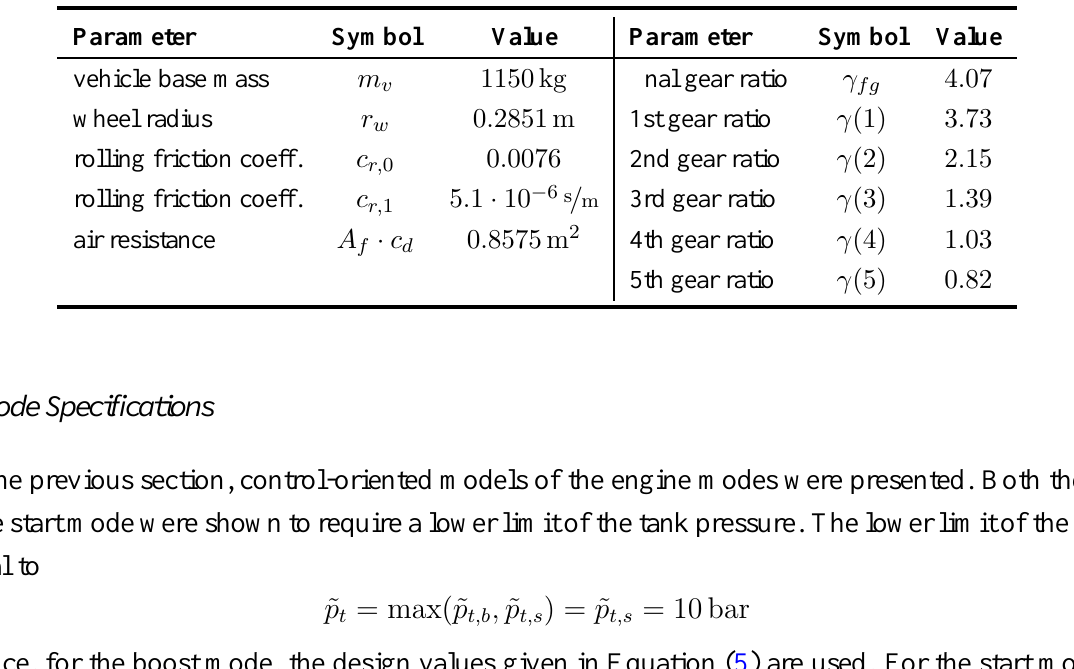
and gear trajectories of the NEDC and the aNEDC on v